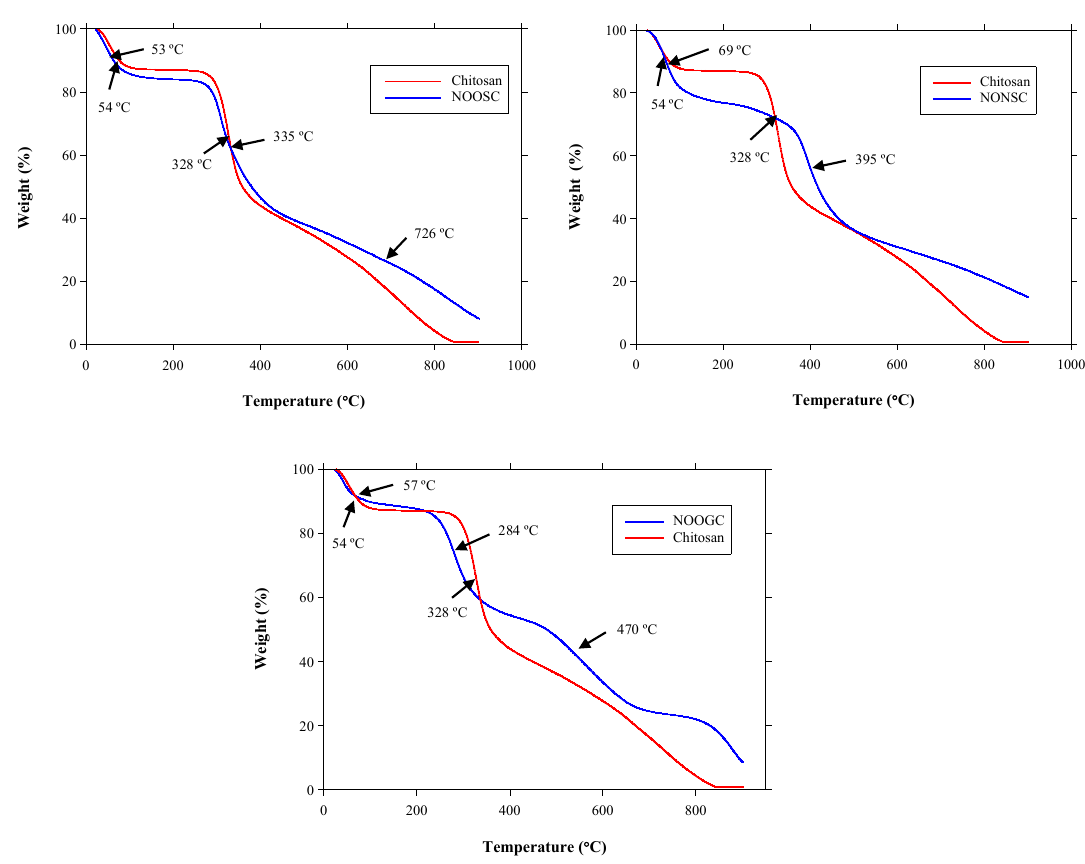
Figure 6: TGA thermograms of chitosan, NOOSC, NONSC and NOOGC.